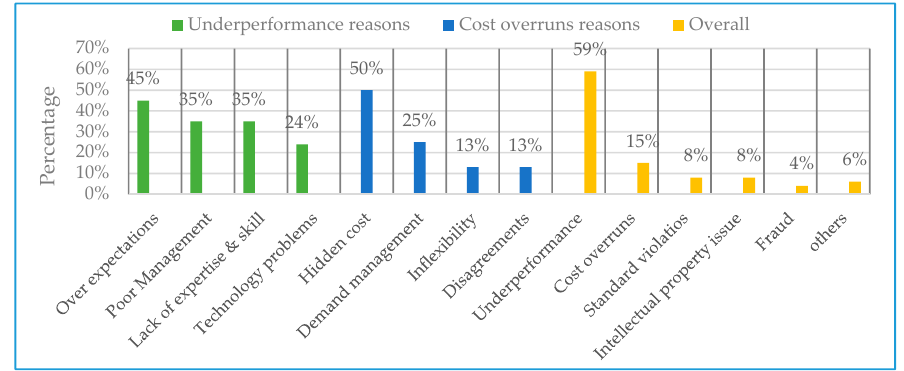
Figure 1. Outsourcing failure reasons. The study was conducted by Deloitte Development LLC in 2005. The participants represented 25 world-class organizations in different sectors. Nearly half of the participants were part of the Fortune 500. Six were part of the Fortune 50, and three were ranked in Fortune Global 100. Ten participants were members of the Dow Jones Composite Index and/or the Standard & Poor’s 500.